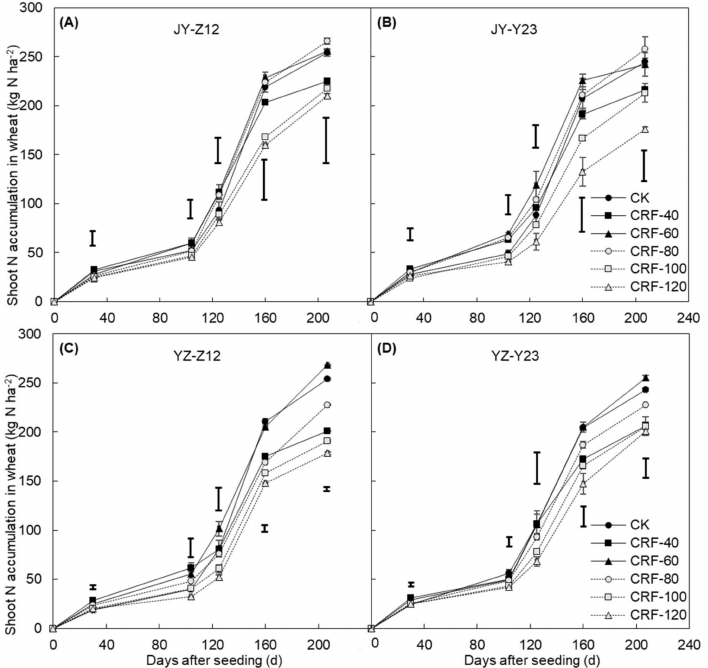
Figure 4. Shoot N accumulation of wheat in different CRF treatments in Jiangyan ( A , B ) and Yangzhou ( C , D ) sites during wheat growing season. Error bars represent SE from mean ( n = 6). Bold bars represent LSD 0 . 05